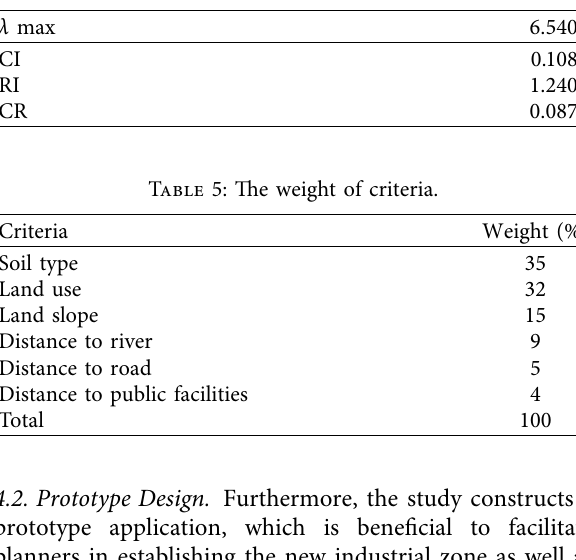
Table 4: Consistency